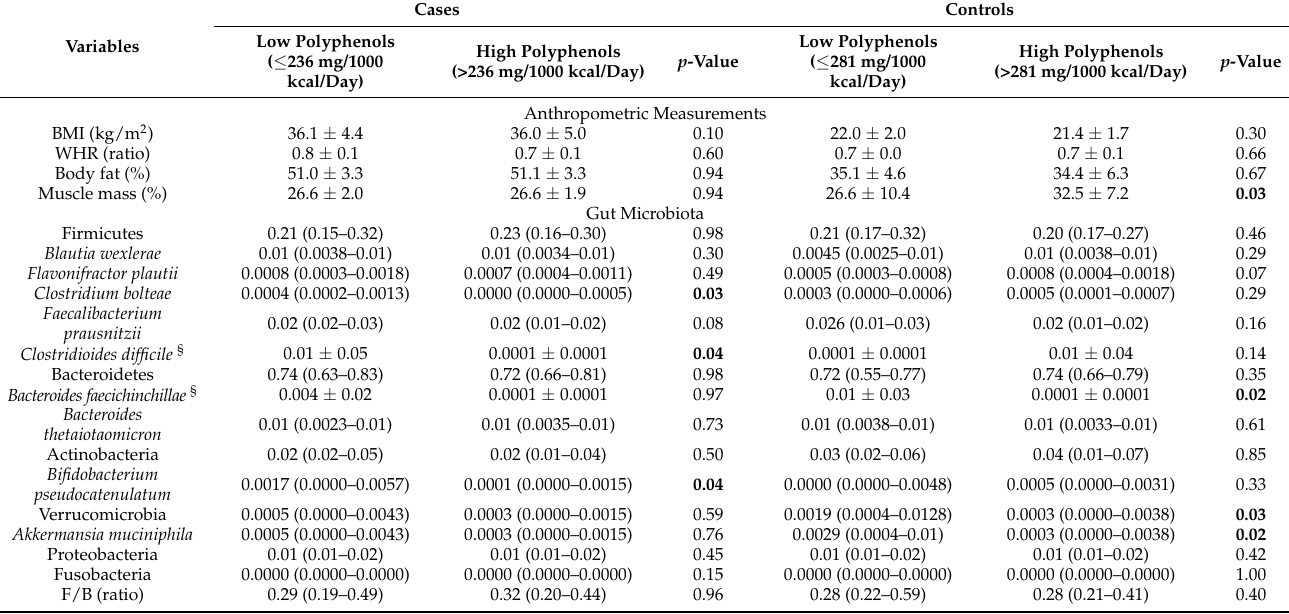
Table 1. Anthropometric measurements and gut microbiota of participants stratified by dietary polyphenol intake and BMI, n =